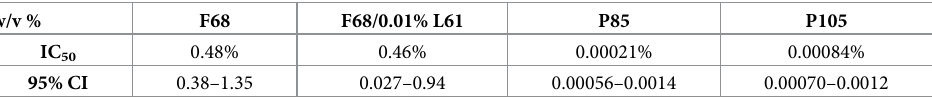
Table 7. The Inhibitory Concentration (IC 50 ) required to reduce number of bsf trypomastigotes by 50%. Pluronic were tested at 12 serial dilutions in triplicate and repeated in 3 separate experiments (n = 3) to produce IC 50 values. w/v %